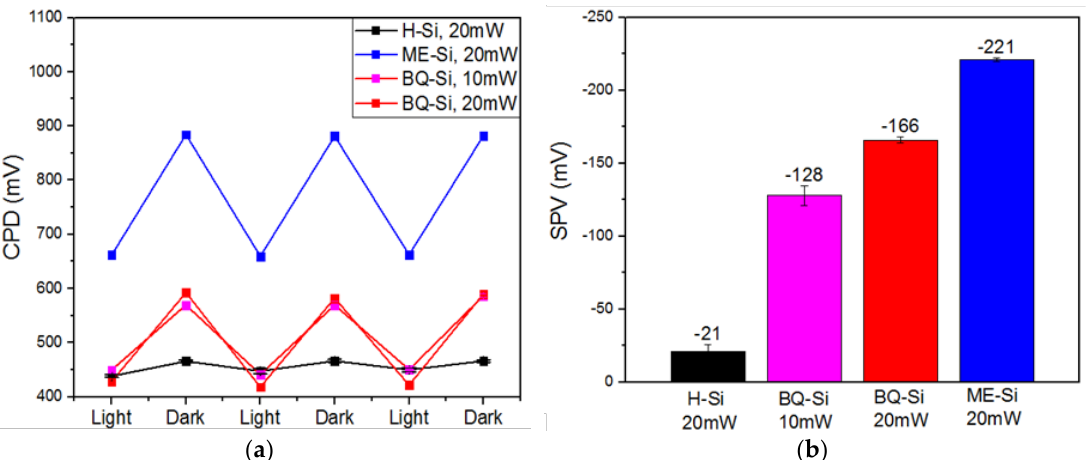
Figure 6. The ( a ) contact potential difference (CPD) and ( b ) surface photovoltage (SPV) measured by Kelvin probe for n-type silicon wafers under three surface treatments—H-Si, BQ-Si, and ME-Si—with respect to HOPG. A reproducible shift of CPD is observed when the 650 nm light was switched on and off during scan.